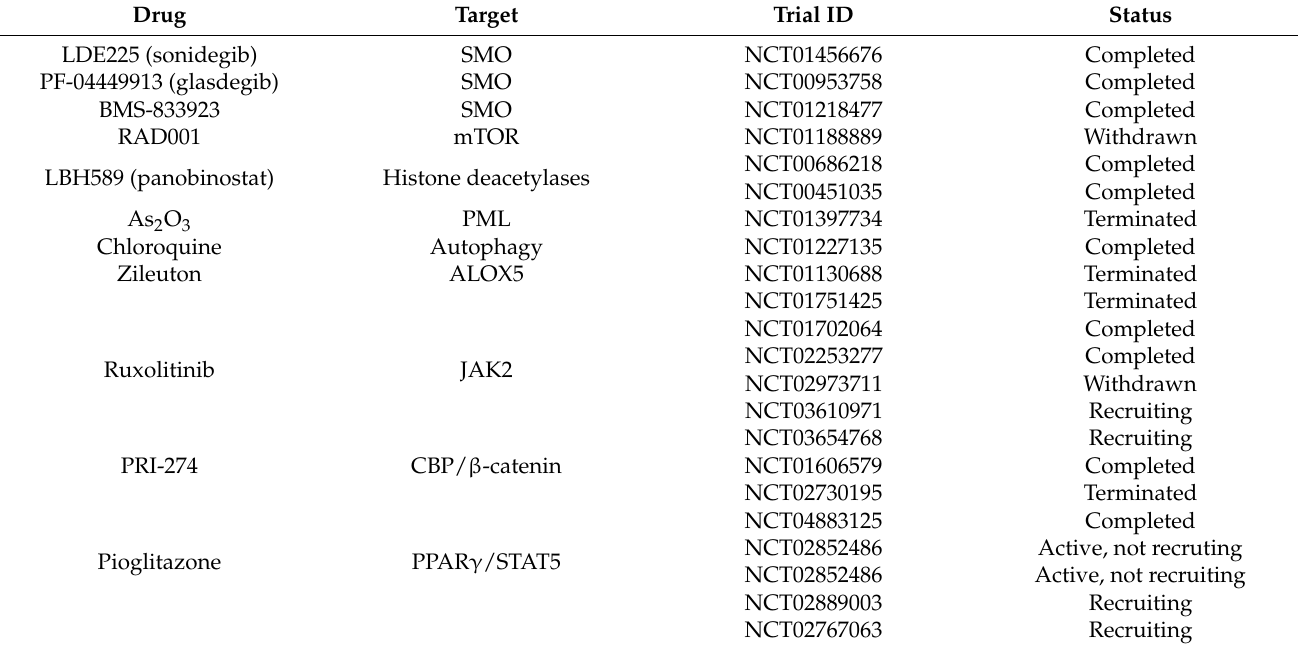
Table 2. List of compounds that have been evaluated, in combination with TKIs, in clinical trials aimed to address LSC-targeting strategies in CML patients (data from